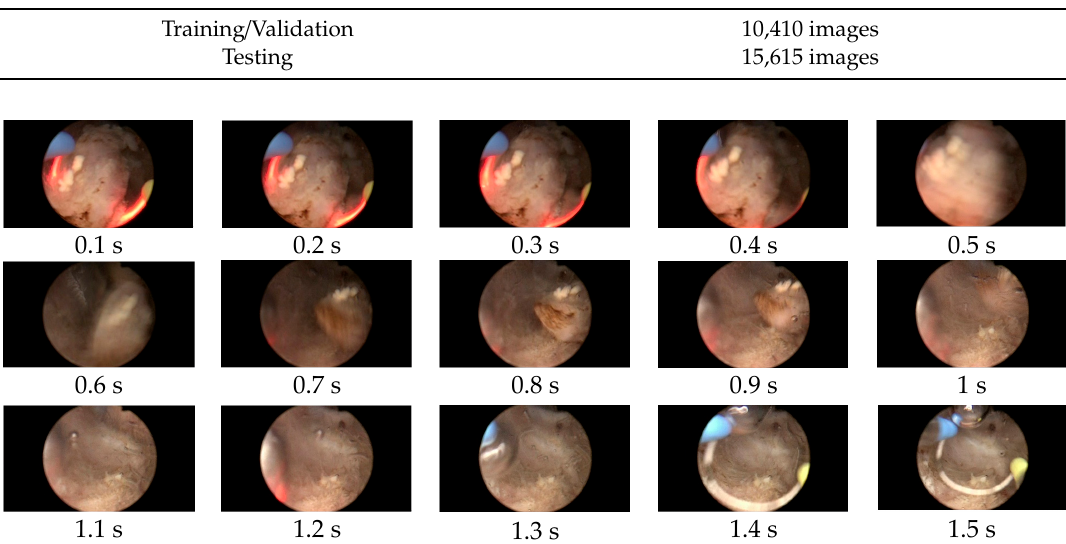
Figure 8. The examples of frames shown per 0.1 s in a video of the prostate surgery (e.g., the meaning of 0.1 s represents the surgery clips at 0.1 s). Table 3. The dataset ratio of the transurethral resection of the prostate (TURP)